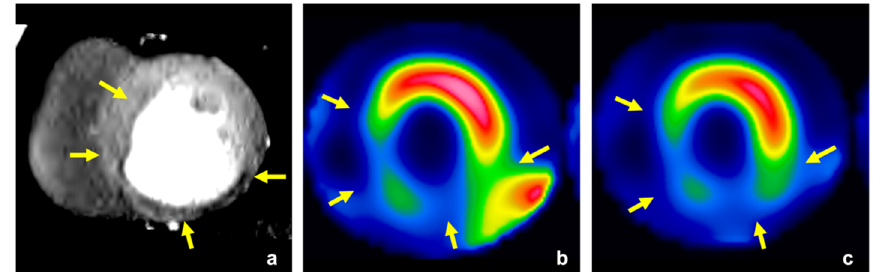
ratio; SPECT, single-photon emission computed tomography; ICA, invasive coronary angiography; LCA, left coronary artery; RCA, right coronary artery; LCX, left circumflex coronary artery.